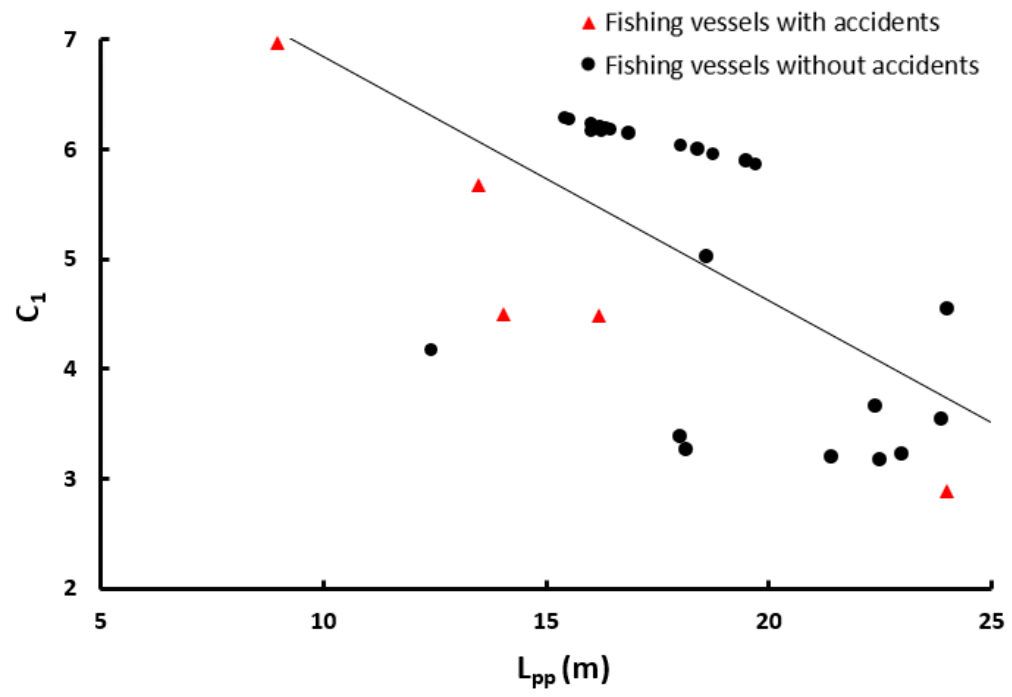
Figure 4. The initial stability coefficient C 1 of the analyzed vessels as a function of the vessel length ( L pp ).